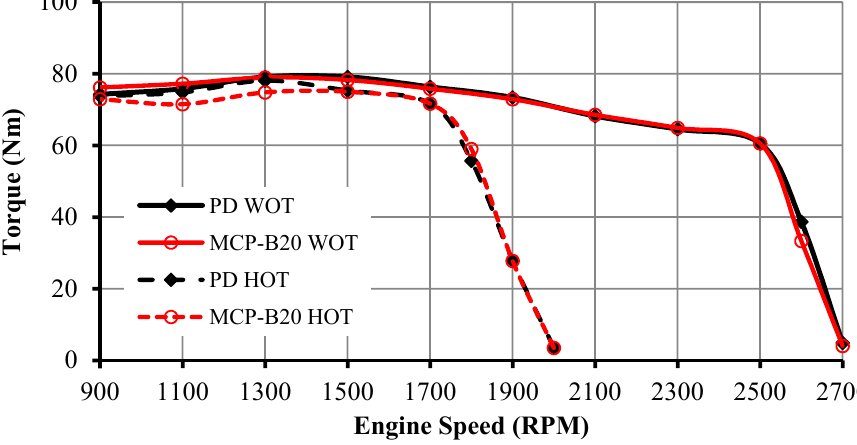
Figure 5. The relationship between tractor engine speeds (RPM) and engine torque (Nm) for PD and MCP-B20.